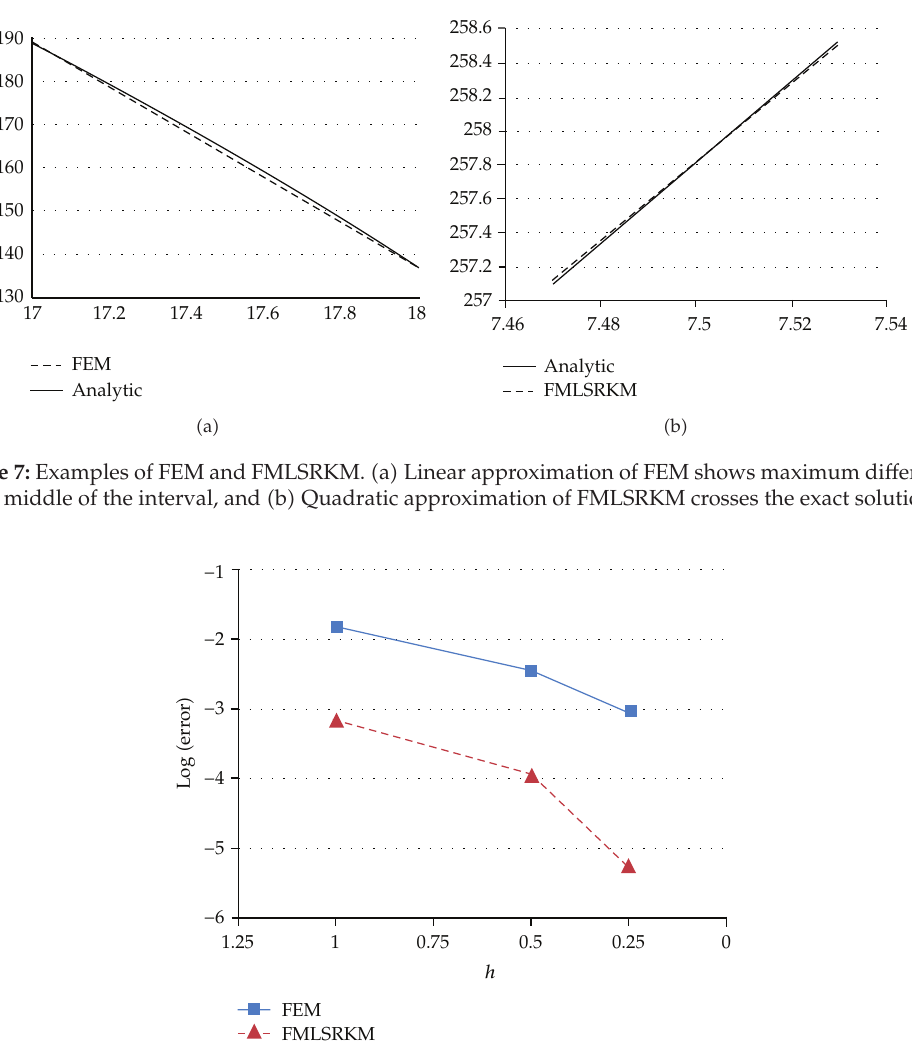
Figure 8: Relative error of FEM and FMLSRKM according to the interval of